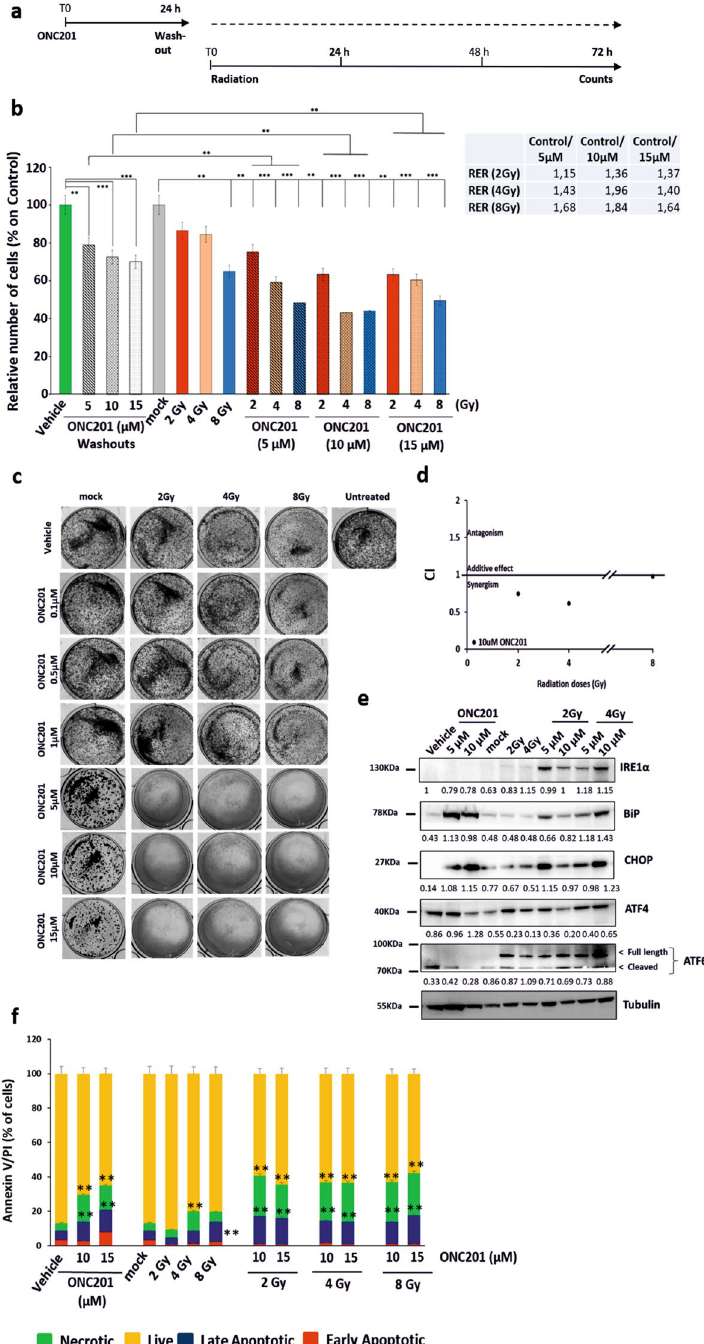
Figure 2. Priming Prostate Cancer cells with ONC201 increases the efficacy of irradiation ( a ) Schematic representation of the treatment in which PC3 cells have been primed with ONC201 before being radiated with single doses of Xrad. ( b ) Cell counts showed that priming PC3 cells to radiation (Xrad) with ONC201 for 24 h impacts cells survival at 72 h. Radiation Enhancement Ratio (RER) is shown for ONC201 (5–15 µM) and Radiation (2, 4 and 8 Gy) and calculated out of 3 independent experiments. ( c ) Clonogenic Assay. Priming PC3 cells to radiation (2, 4 and 8 Gy) with ONC201 (0.1–15 µM) for 24 h prevents colony formation for concentrations higher than 1 µM. The cells were treated with ONC201 for 24 h and then either mock irradiated or irradiated with the indicated doses. Post-treatment, the cells were cultured in clonogenic conditions and photographed after 1 week (Images representative of n = 3). ( d ) ONC201 10 µM has a synergistic effect with all doses of radiation (2, 4 and 8 Gy) at 72 h (CompuSyn). ( e ) Western Blot analysis of the expression of the main components of the UPR upon priming PC3 cells to radiation (Xrad) with ONC201 for 24 h. Samples were harvested at 72 h from the irradiation (Representative of n = 3). Densitometric analysis of n = 3 WB are shown in Supplementary Fig. 2c. Here the average is expressed as a number embedded within the figure (the SD are within the 5% acceptance of statistical significance).The membranes were cut before the incubation with the primary antibody (see “Materials and methods” for specifications) and either detected alone or together. All the membranes were exposed for 3 min, with the exception of ATF4 and ATF6 (exposed for 6 min), PERK and Tubulin (exposed for 2 min). ( f ) Cell death analysis through Annaxin V/PI detection of PC3 treated with ONC201 (5 and 10 µM) and Radiation (as described in ( a )). Samples were harvested at 72 h. One-way ANOVA test has been run comparing treated vs Vehicle and No Radiation on n = 3 experiments, *p ≤ 0.05; **p < 0.01; ***p < 0.001 (±